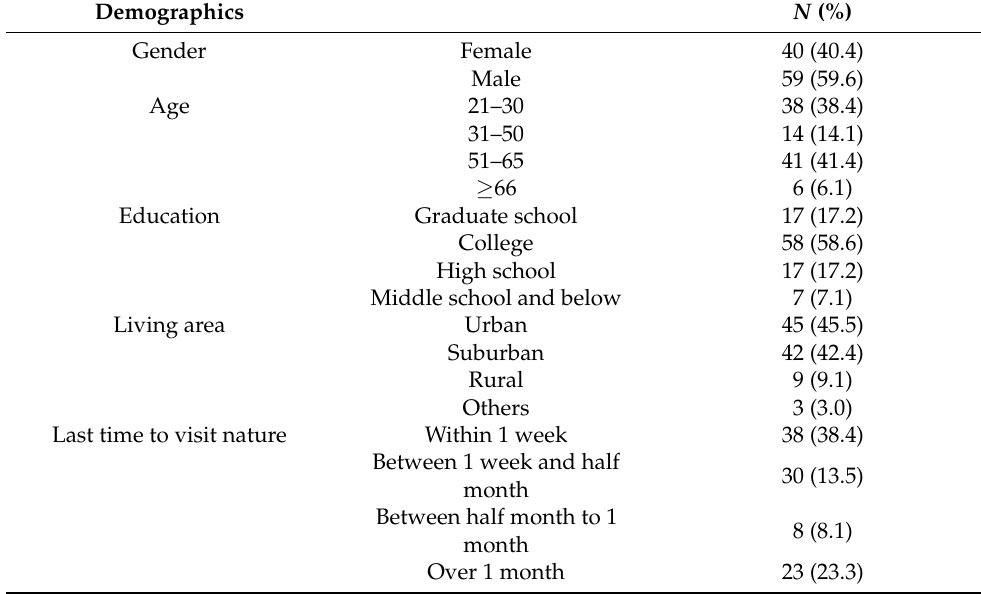
Table 3. Demographic characteristics of study participants ( N = 99).